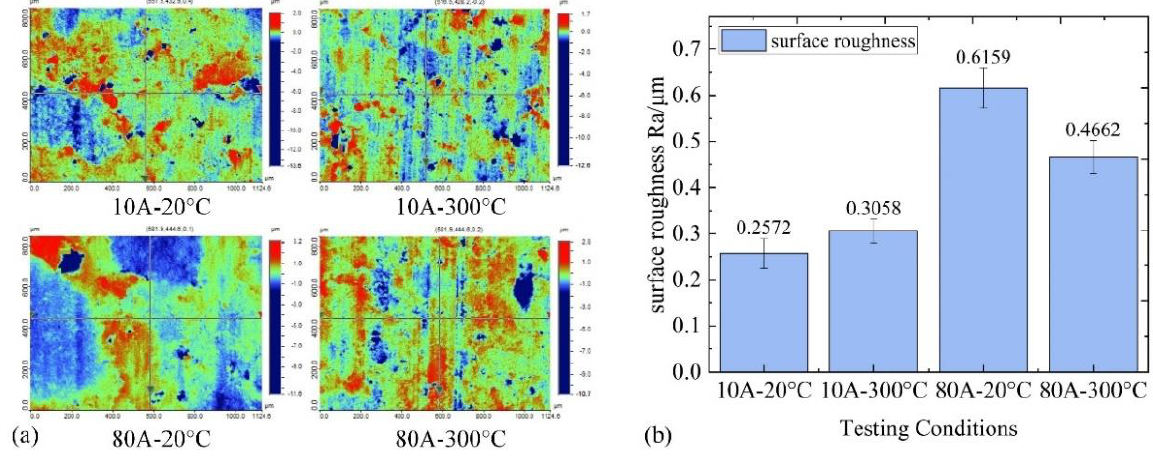
Figure 12. 3D morphologies and surface roughness of the carbon slider at different interface temperatures and currents: ( a ) 3D morphologies and ( b ) surface roughness.